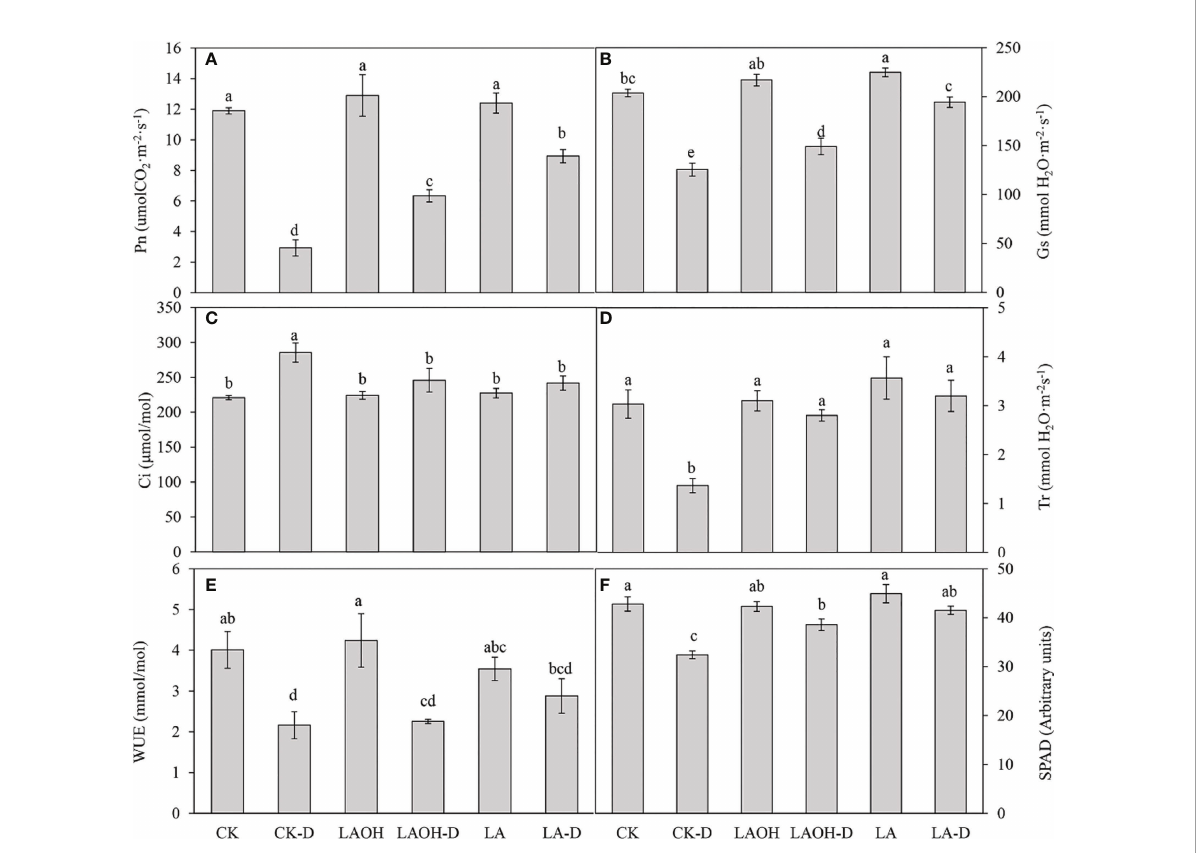
FIGURE 3 Effects of LA-OH and LA on the photosynthetic characteristics of P. persica under drought stress (A) Pn; (B) Gs; (C) Ci; (D) Tr; (E) WUE; (F) SPAD). Data are mean ± SD (n = 3). Duncan ’ s test and ANOVA were used. Signi fi cant differences (P < 0.05) are indicated by different